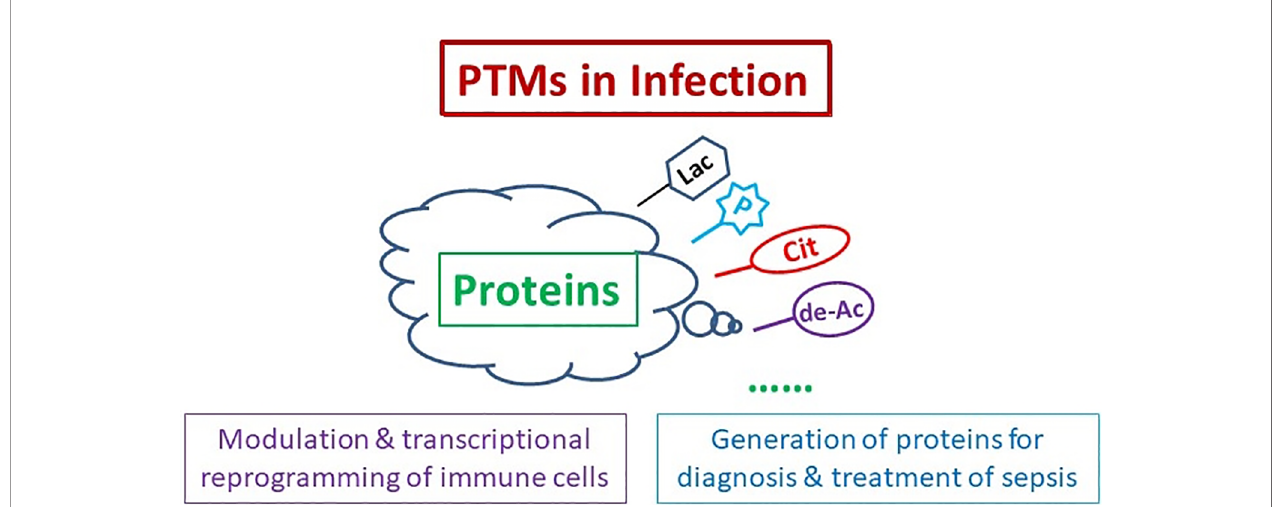
FIGURE 1 | Protein Post-translational Modi fi cations (PTMs) for Diagnosis and Treatment of Sepsis. PTMs of proteins participate in modulation and transcriptional reprogramming of immune cells, and generation of the proteins for sepsis diagnosis and treatment. Cit, citrullination; de-Ac, deacetylation; Lac, lactylation; P,